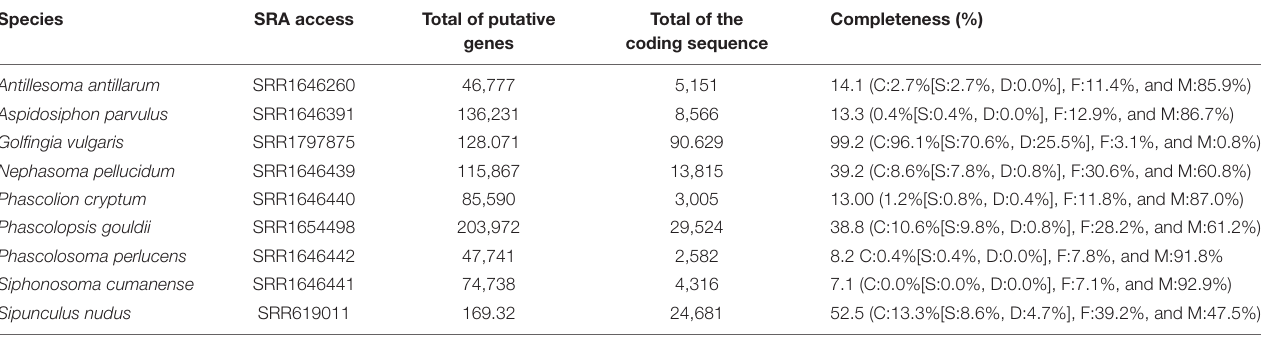
TABLE 1 | RNA-Seq assembly details of Sipuncula species used in this study. Species SRA access Total of putative